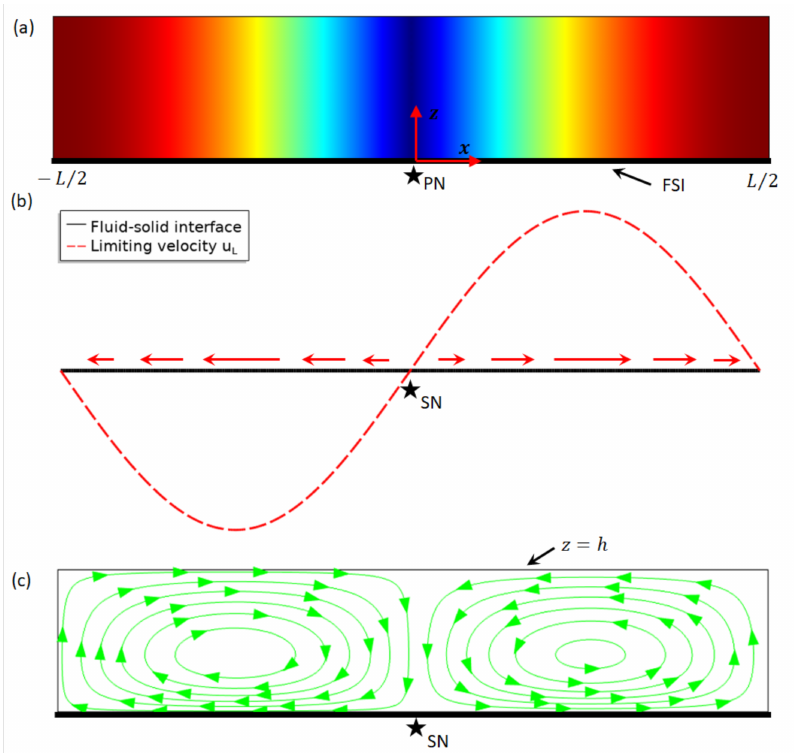
Figure 1. Acoustofluidic fields in a symmetric one-dimensional acoustic resonance over a fluid–solid interface (FSI). ( a ) Acoustic pressure magnitude | p 1 | for S 0 = 0 over the FSI in a one-dimensional standing wave field (red and blue for maximum and 0, respectively); ( b ) the limiting velocity field u L (see Equation (4)) over the FSI; and ( c ) outer acoustic streaming in a confined fluid driven by the limiting velocities of a half-wavelength standing wave. PN and SN represent locations of acoustic pressure node and acoustic streaming node,